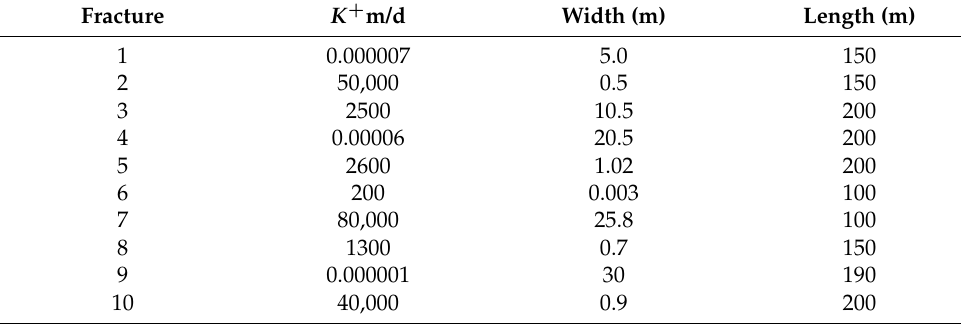
Figure 5. 10 fractures with different hydraulic conductivities, apertures and lengths having an angle of 45 ◦ in a uniform flow field. Table 2. Hydraulic conductivities, widths and lengths for Figure